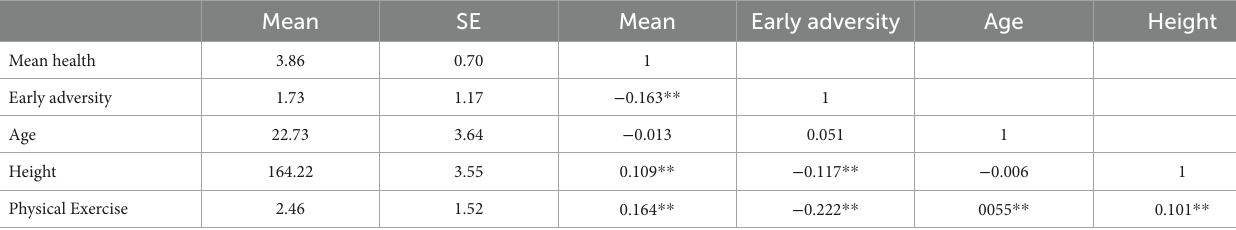
TABLE 1 Descriptive statistics and Pearson correlation analysis of key variables ( N =